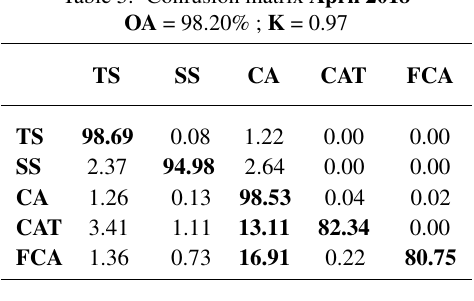
Table 11. Confusion matrix October 2018